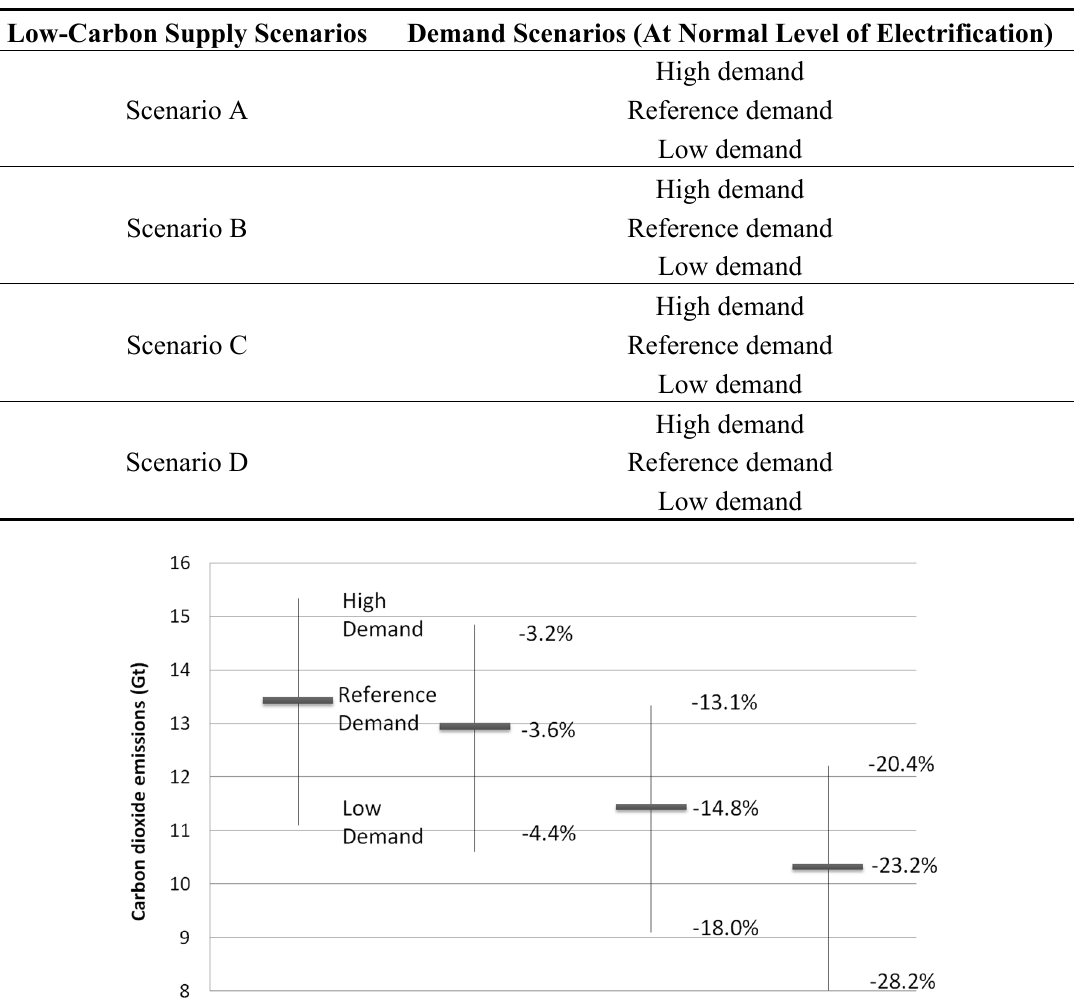
Table 12. Scenarios used for analyzing contributions of low-carbon supply to carbon dioxide mitigation with different demand trends.